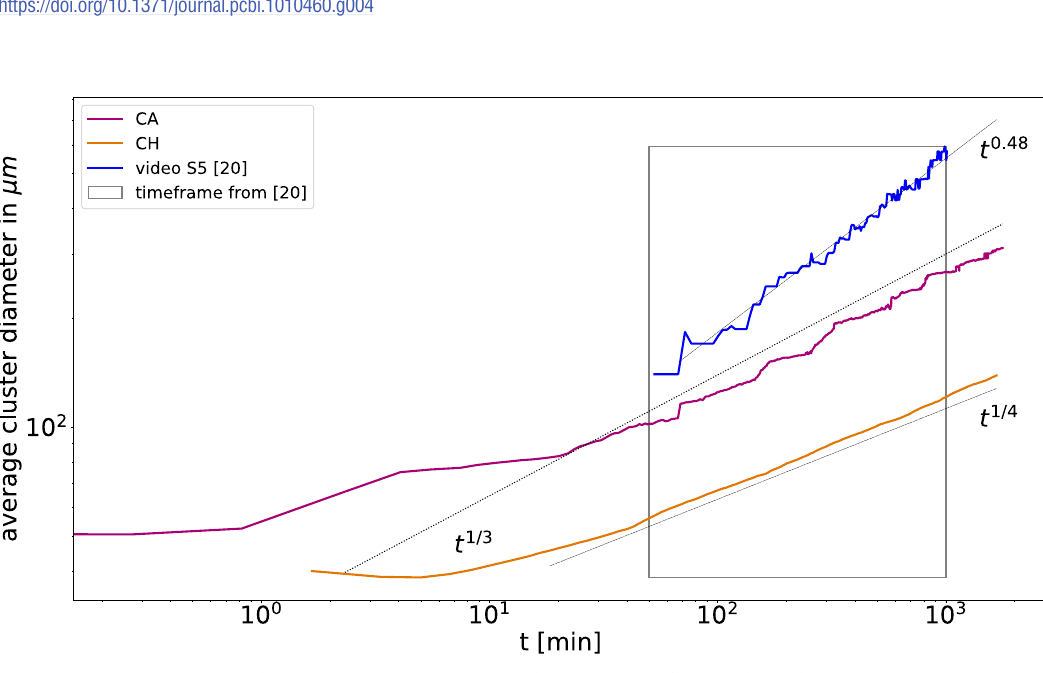
Fig 5. Exemplary comparison of the average cluster diameter in the segregation of PFK and EPC for the cellular automaton model (red line), the Cahn-Hilliard model (orange line) and the experimental data (blue line, based analysis of video S5 of Me´hes et al. [20]) computed with two-point correlation method, see Materials and methods. Note that average cluster diameter in both models, cellular automaton and Cahn-Hilliard, are inverse proportional to their segregation indices. In contrast, the average cluster diameter obtained for the experimental data displays a steeper power law than expected from the corresponding segregation indices.